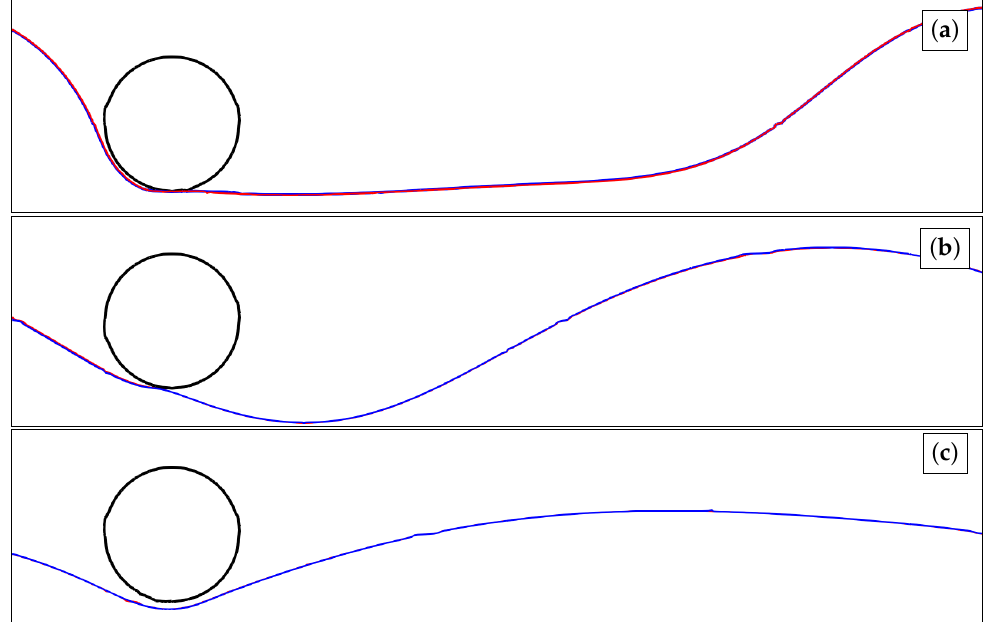
Figure 16. The same as in Figure 15 except for the presence of a thin film of fluid 2, with a thickness of δ = 0.05 R s on the solid surface. The level of refinement used is J max = 8. The results are shown at times: ( a ) t = 0.625; ( b ) t = 1.625; ( c ) t = 2.625 for a moving (blue) and fixed (red) cylinder. Notice that the blue and red curves are nearly coincident in all